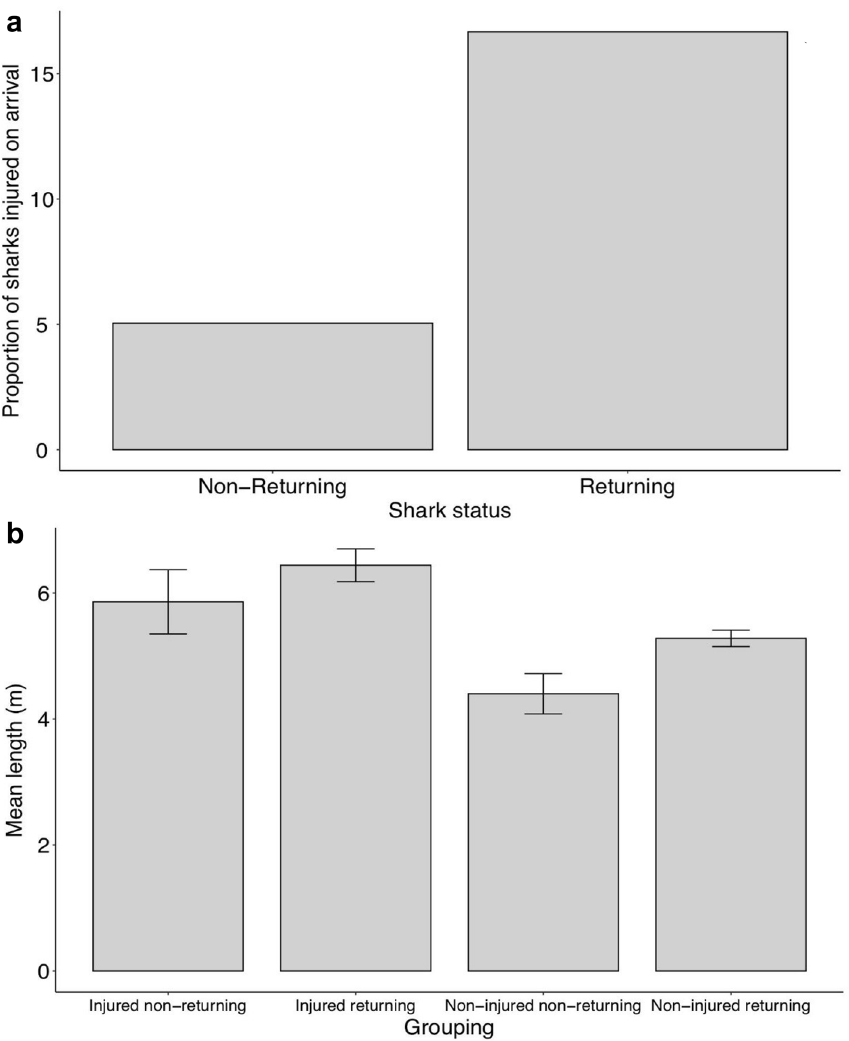
Figure 8. ( a ) Proportion of individual sharks with major injuries on arrival that return the following year vs. non-returning individuals between the years of 2006–2019. ( b ) Mean length (with SE) of resident and transient whale sharks with and without major injuries for the years